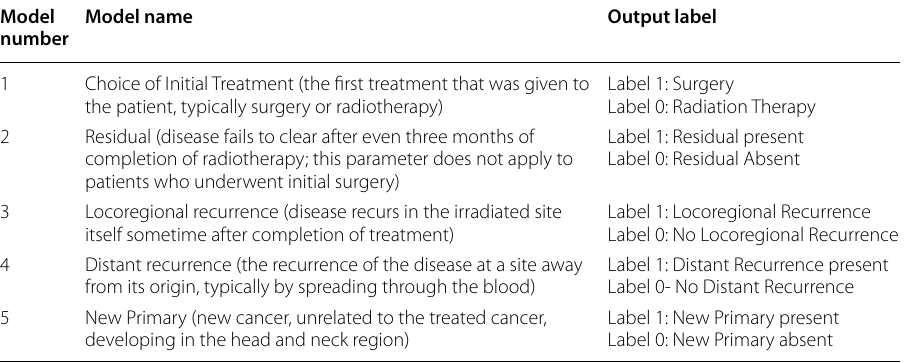
Table 2 Classification models designed along with their respective encoded output vectors Model Model number